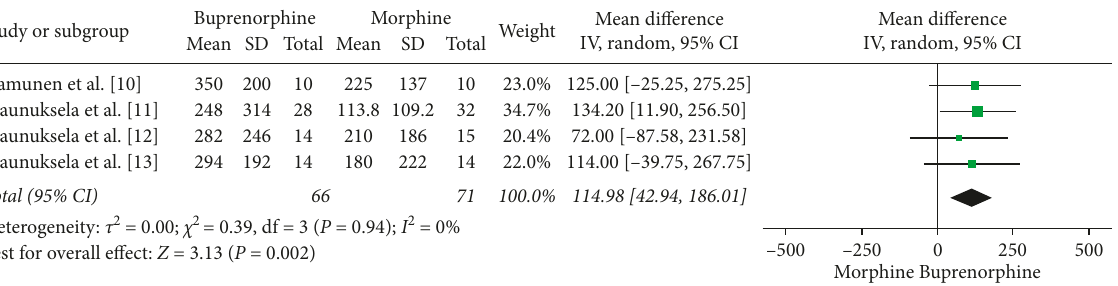
Figure 3: Time to breakthrough analgesia.